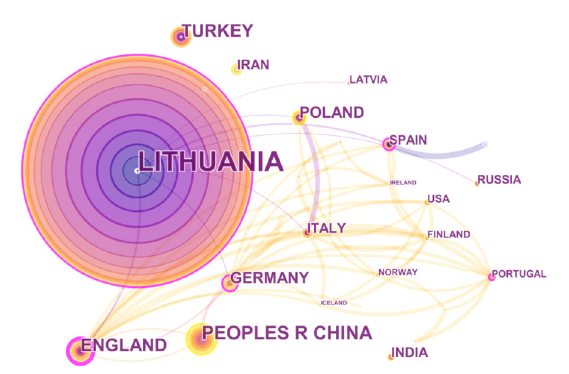
Figure 4. A visualization of the country collaboration network